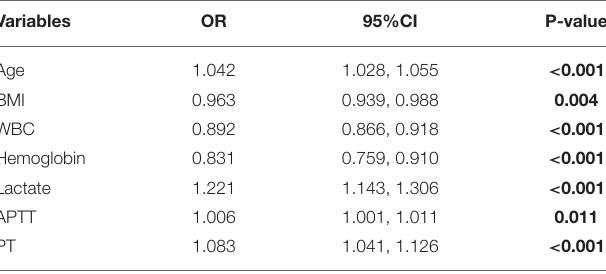
TABLE 2 | The risk factors of postoperative thrombocytopenia in multivariable logistic regression